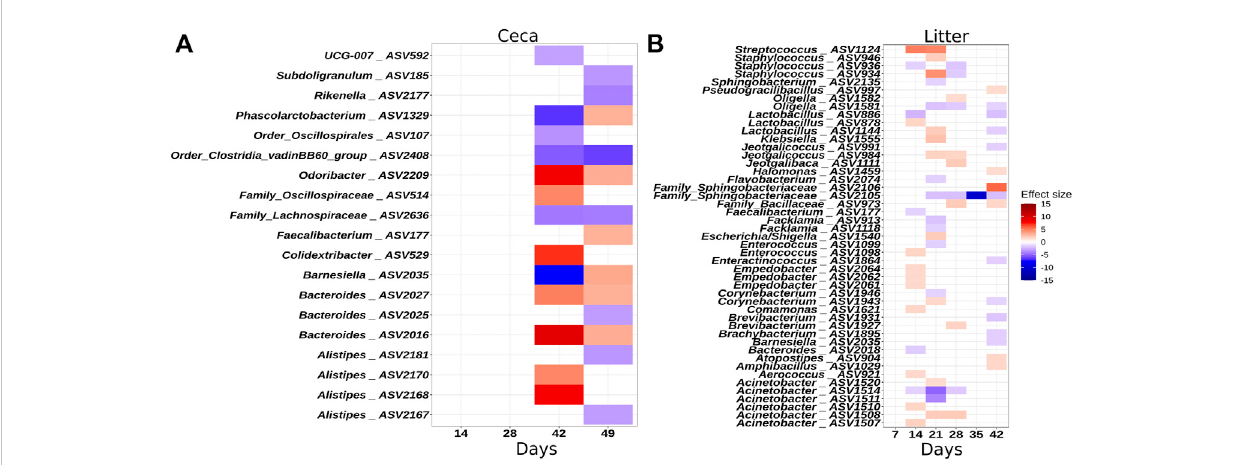
Heatmaps illustrating ASVs that were signi fi cantly differentially abundant between houses. (A) Ceca samples. (B) Litter samples. The effect size depicts the negative log of the q-value multiplied by the sign of the coef fi cient. A positive effect size denotes higher abundance in house 2. A negative effect size denotes higher abundance in house 1. Taxonomy of the ASVs is indicated at the genus levels or at the lowest rank that could be assigned con fi dently (Bootstrap support above 50). Only signi fi cant changes are shown.